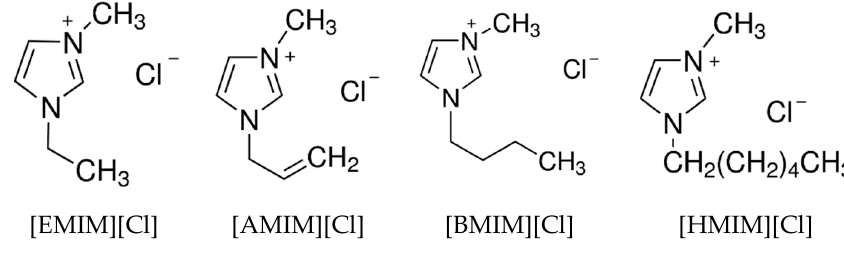
Figure 8. Chemical structures of ILs. Table 2. Chemicals employed with purities.